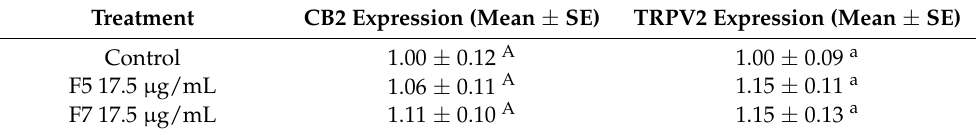
Control was the vehicle control (1% v / v methanol). Gene transcript values were determined by quantitative PCR as a difference between the target gene versus a reference gene (HPRT). Values were calculated relative to the average expression of target genes in treated versus control using the 2 − ∆∆ Ct method. Levels with different Upper or lower case letters with the same font and style were significantly different from all combinations of pairs by Tukey–Kramer honest significant difference (HSD; p ≤ 0.05; n =